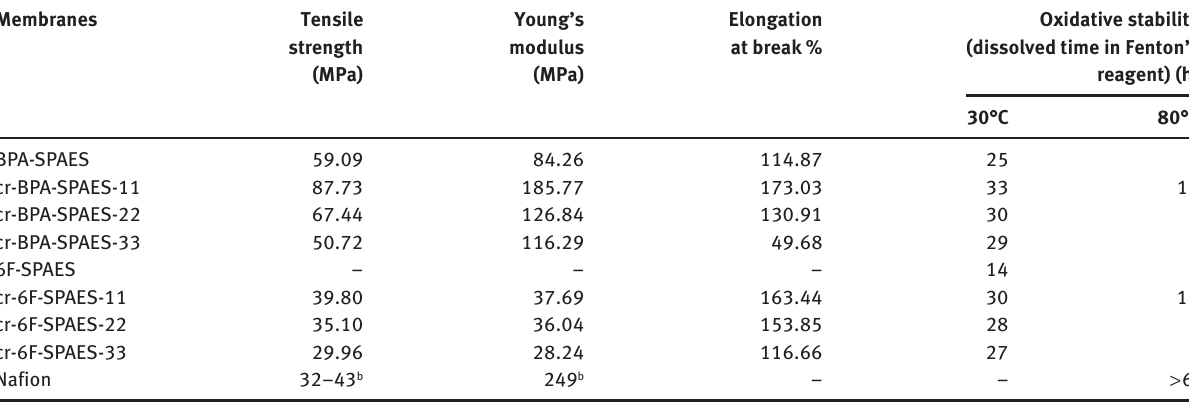
Table 2: Mechanical properties and oxidative stability of the SPAES membranes.